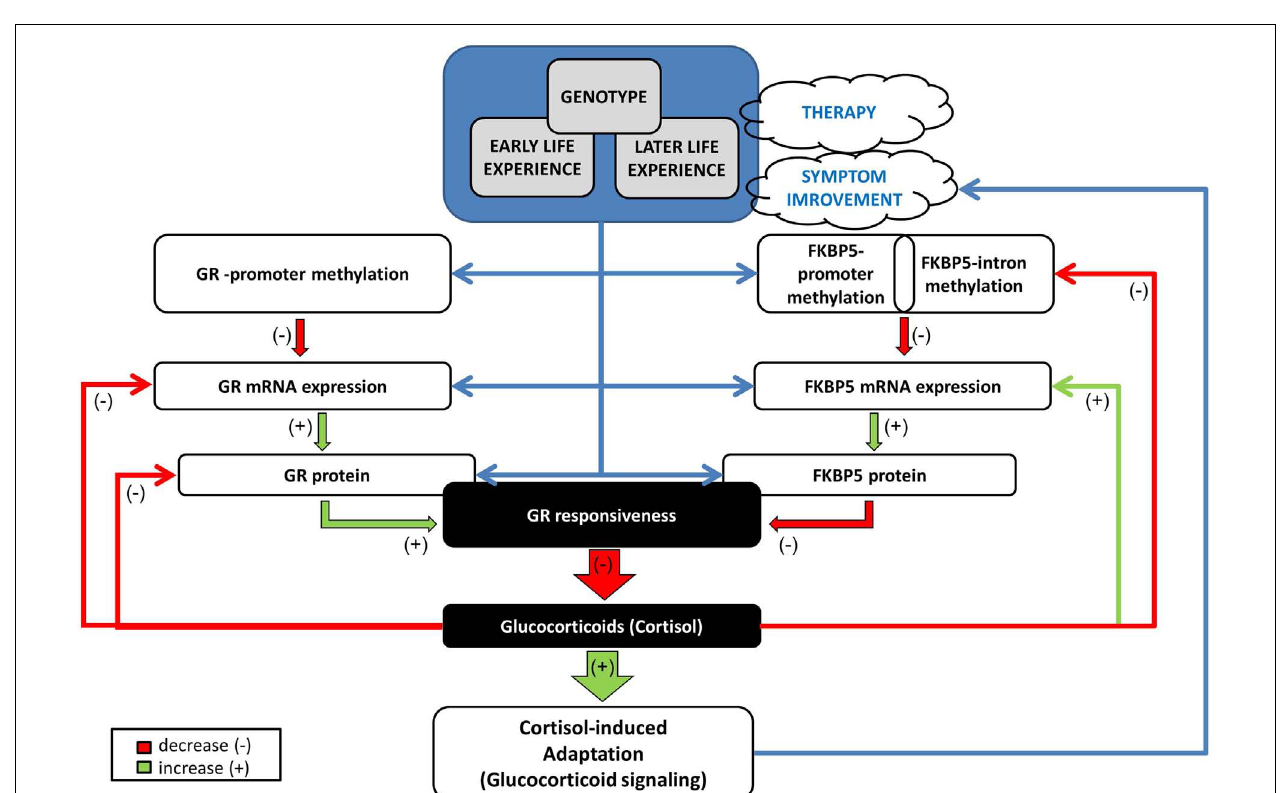
subsequent increase in FKBP5 mRNA and protein expression, which would, in turn, ultimately decrease GR responsiveness, permitting the normalization of cortisol and of glucocorticoid signaling.This would have a beneficial effect on PTSD symptoms by impacting glucocorticoid responsive DNA sites that reduce sympathetic arousal or stimulate adaptation and recovery/resiliency (e.g., neuropeptide-Y). Green arrow denotes a positive influence (increase, “ + ”) and red arrow a negative influence (decrease, “ − ”). Blue arrow depicts a relationship. GR: glucocorticoid receptor encoded by the NR3C1 gene, FKBP5: FK506 binding protein 5 encoded by the FKBP51